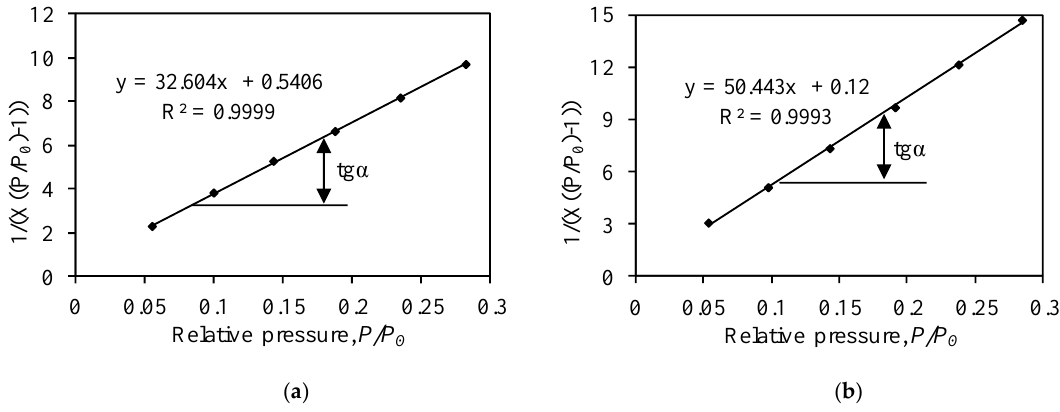
Figure 6. Isotherm of N 2 adsorption at 77 K in BET plot of synthetic ( a ) and calcined ( b ) samples. Table 1. Calculated parameters of synthetic and calcined samples by BET method.